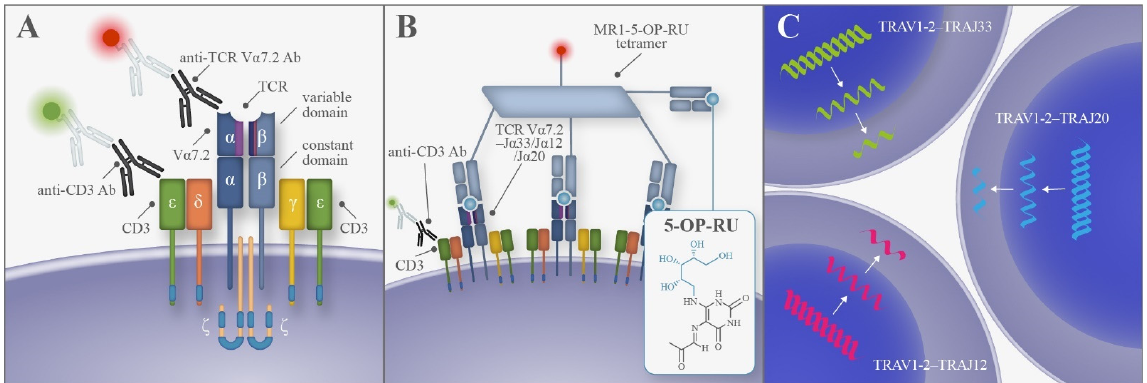
Figure 1. T-cell receptor (TCR) restriction in MAIT cells and their identification: ( A ) MAIT cells are T lymphocytes (CD3 + cells) that express a semi-invariant TCR including the V α 7.2 segment associated with a limited selection of J α segments (J α 33, J α 12, or J α 20). Available antibodies can individually recognize the V α 7.2 segment and CD3; ( B ) TCR of MAIT cells can bind non-protein antigens, such as the potent activator 5-(2-oxopropylideneamino)-6-D-ribitylaminouracil (5-OP-RU),